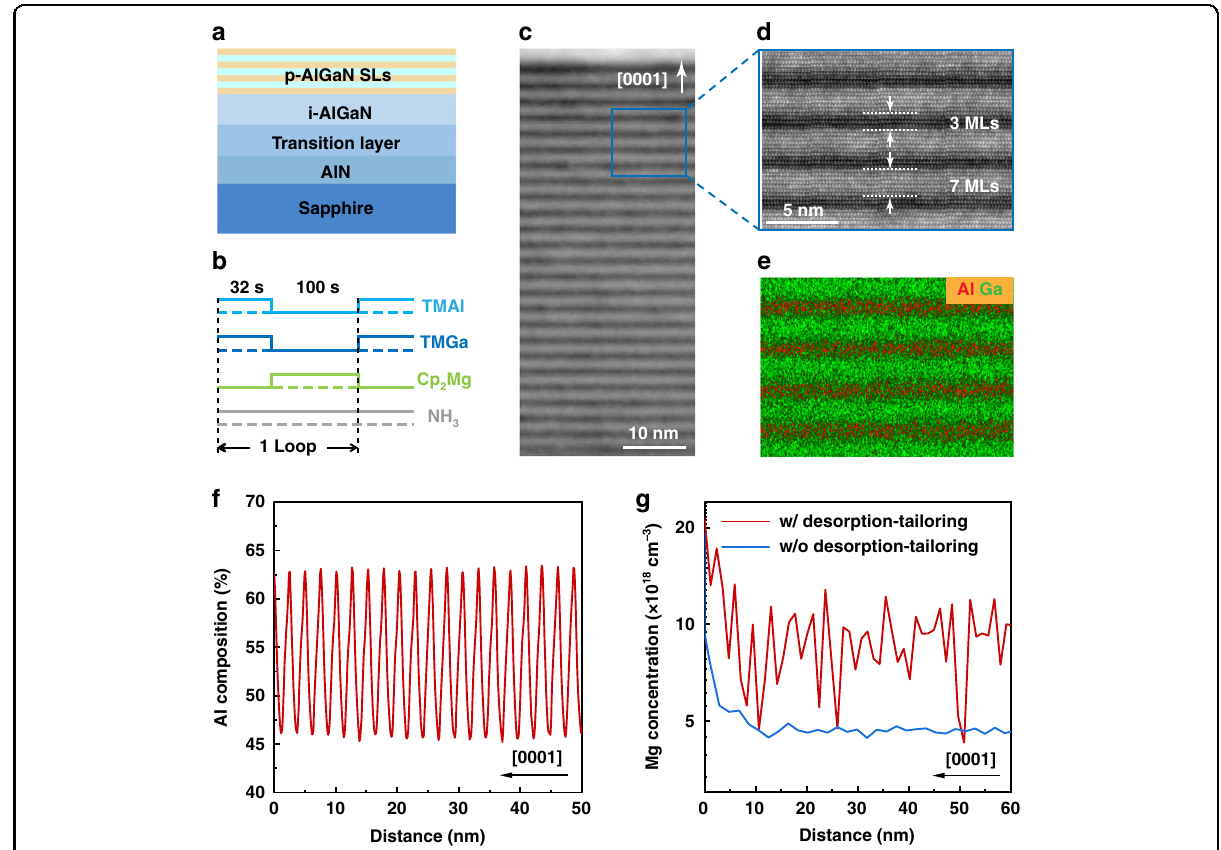
Fig. 2 Preparation of Al-rich p-AlGaN SLs by adopting the desorption-tailoring strategy. a Schematic illustration of the sample with desorption-tailored p-AlGaN SLs. b Schematic process of desorption-tailoring for p-AlGaN SLs. c HRTEM image of the p-AlGaN SLs. d Z-contrast image of the p-AlGaN SLs. e Distribution of Al and Ga atoms by EDS mapping corresponding to the region in panel d . f EDS line scanning curve of Al composition in the p-AlGaN SLs. g Mg concentration pro fi le by SIMS in the desorption-tailored p-AlGaN SLs as well as in an uninterrupted-grown Al 0.63 Ga 0.37 N epilayer (without